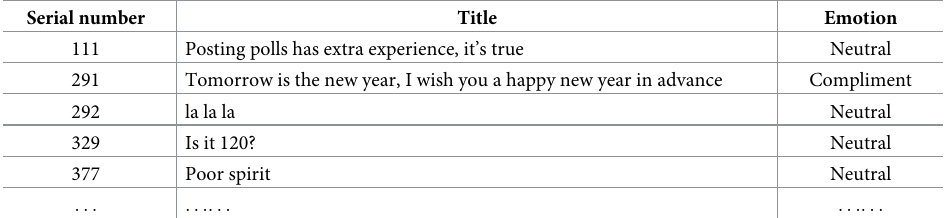
Table 9. Cases of irrelevant user participation in the "Lilac Forum" during the